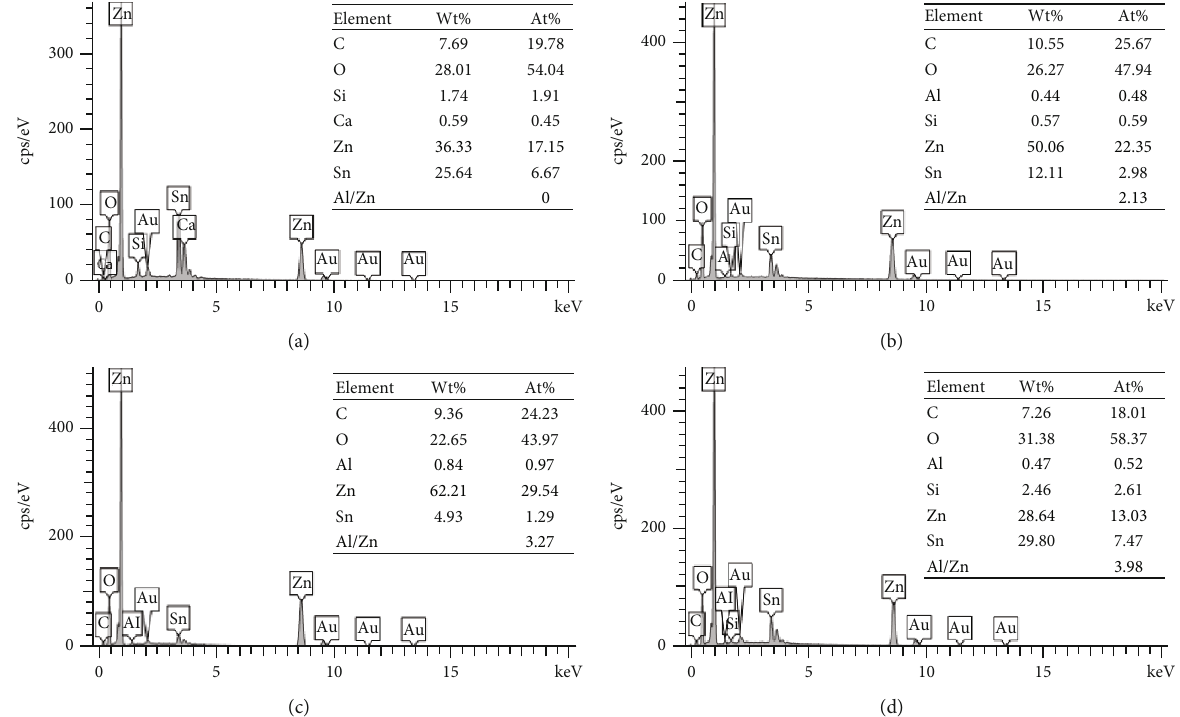
Figure 4: Energy dispersive analysis of X-ray spectra (EDS) for the ZnO samples corresponding to the SEM images in Figure 3.